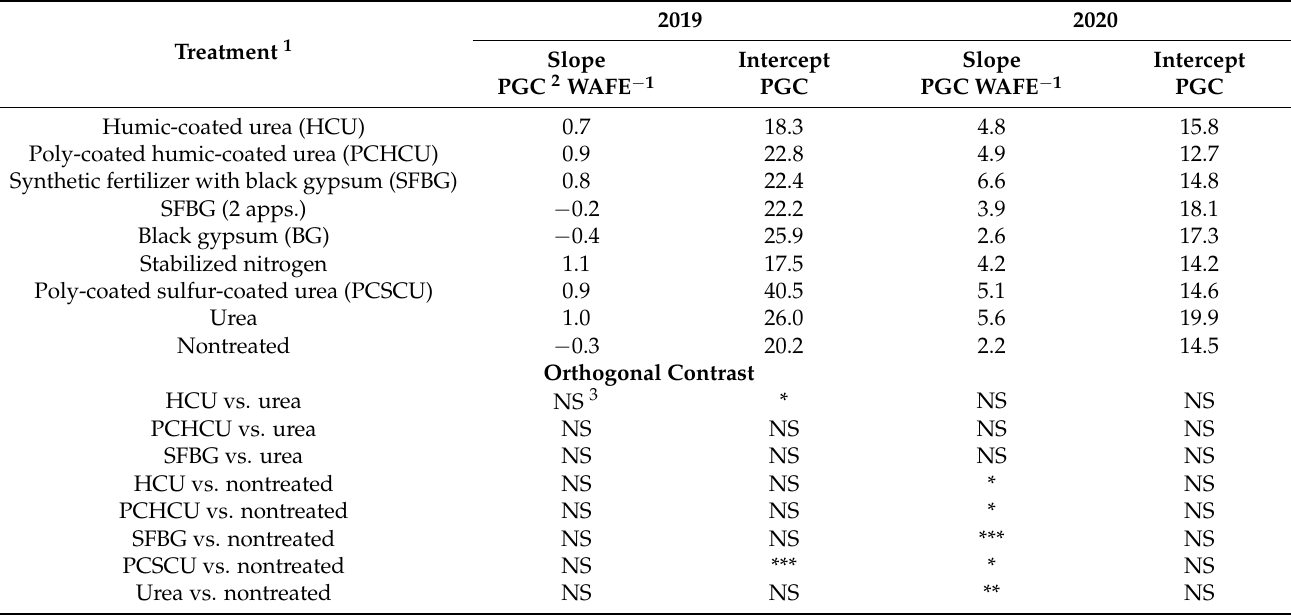
Table 3. Effects of various fertilizers on percent green cover (PGC) of a native soil Kentucky bluegrass ( Poa pratensis L.) after simulated traffic concluded in fall of 2019 and 2020 in Ames, IA,